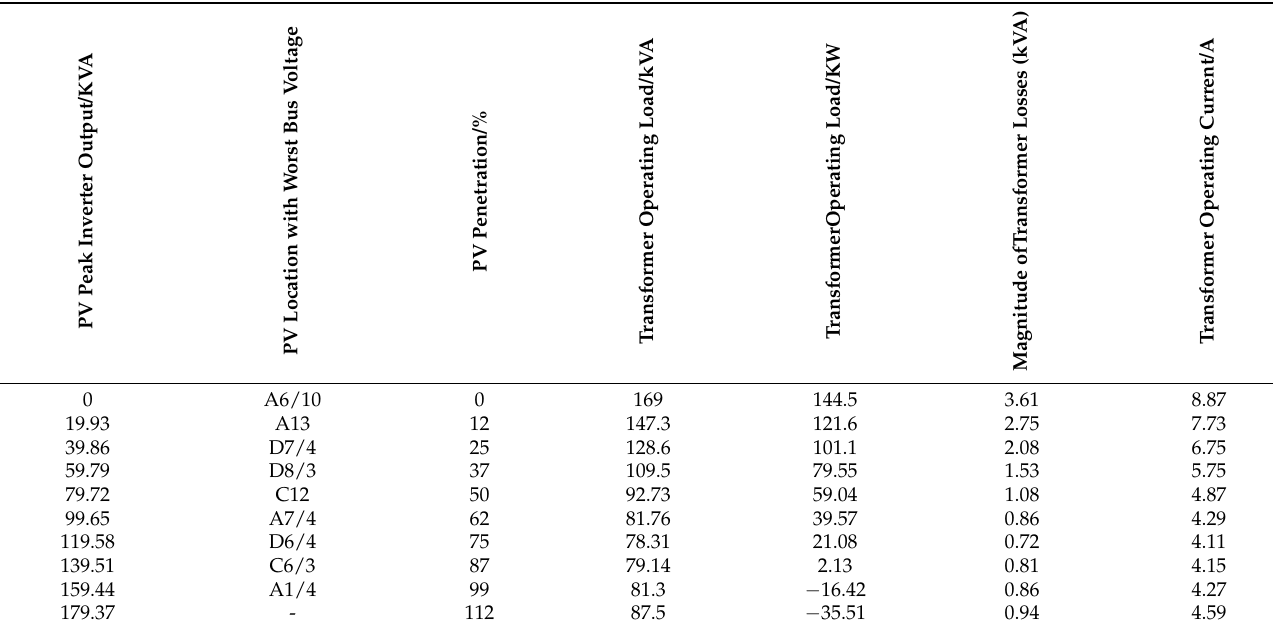
Table 6. Summary of simulation results of PV-solar-integrated real urban ECG